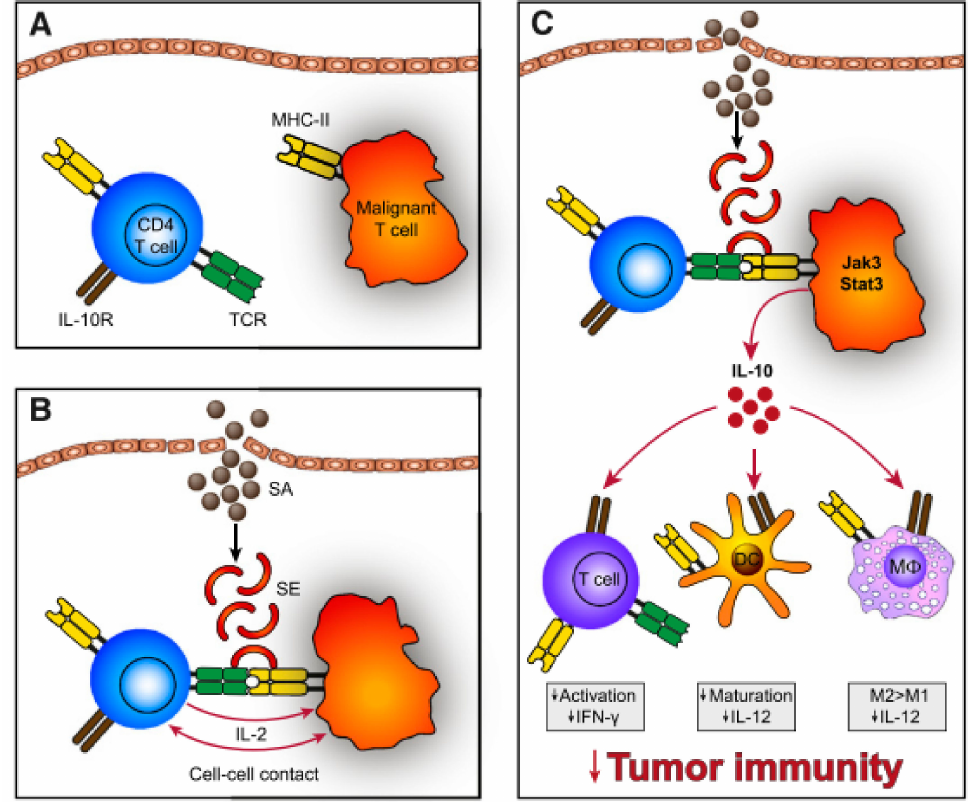
Figure 4. ( A ) Malignant T-cells often express a monoclonal TCR-V-beta chain with decreased function of the whole TCR complex. Hence, SEs do not stimulate the TCR directly but through activation of benign T-cells. ( B ) SEs bind to MHC II expressed on malignant T-cells, which crosslink to TCR of benign T-cells. Subsequently, establishing T-T-cell interaction and IL-2 is expressed. ( C ) These signals induce IL-10 expression, which dampens the immune response via impaired maturation of DCs, repressed expression of Th1 cytokines (interferon-g, IL-12), inhibition of T-cell activation and promoted development of M2 macrophages. Reprinted with permission from ref. [105]. Copyright © 2014 American Society of